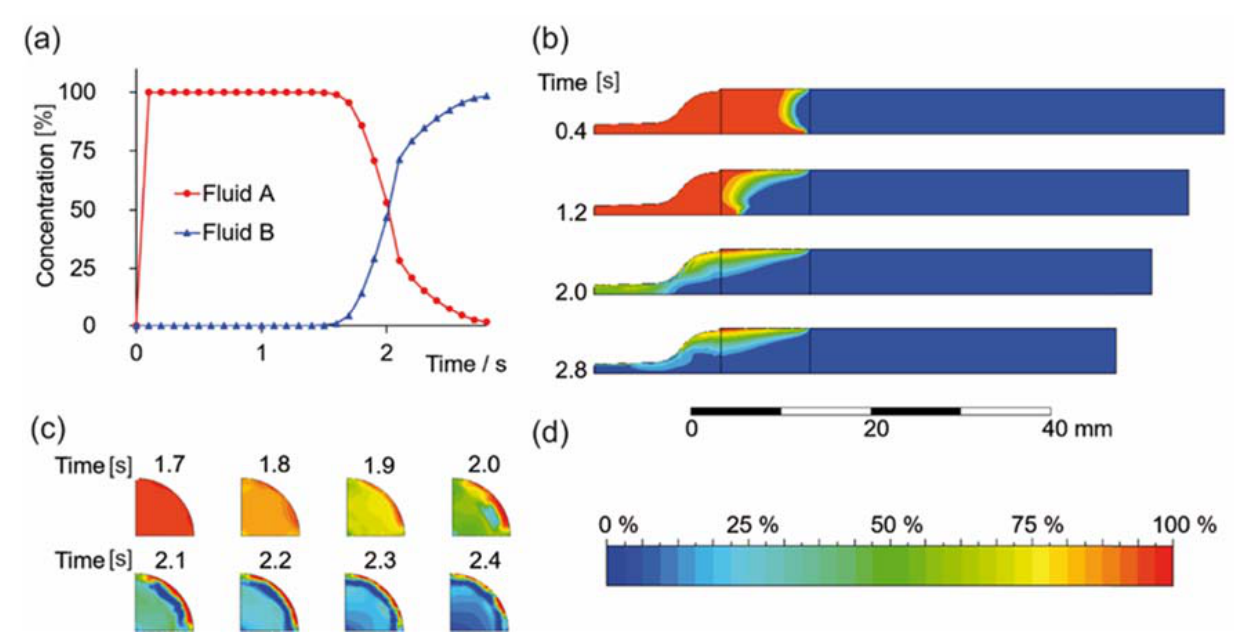
Figure 1. Flow simulation results. ( a ) Concentration of fluid A and B of an AB block system in a printing cartridge at the outlet during the extrusion process. ( b ) The concentration profile within the cartridge during extrusion shows a back mixing effect in the cartridge clip plane. ( c ) Occurring core-shell effect before the final material extrusion of fluid A at the outlet (cross section). ( d ) Color scale for ( b ) and ( c ), depicting fluid A in red and fluid B in blue (blue means 0% fluid A).